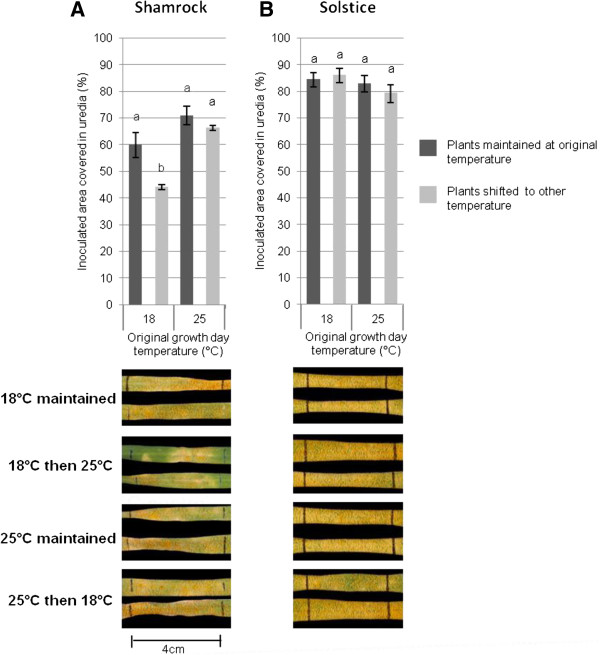
The effect of changes in temperature on yellow rust resistance in wheat cultivars Shamrock and Solstice. Percentage (%) leaf area covered in uredia 18 dpi with Pst isolate 08/21 when kept at the same temperature regime of 12°C/18°C or 12°C/25°C pre and post inoculation (dark grey) or transferred to the other temperature regime post inoculation (light grey). Wheat cultivars A) Shamrock and B) Solstice. The Pst inoculated area is bounded by black, vertical lines. Mean values (± 1 standard error) were obtained from at least two independent experiments where cultivars Shamrock and Solstice were inoculated at the same time. Different letters indicate statistically significant differences (P <0.01).